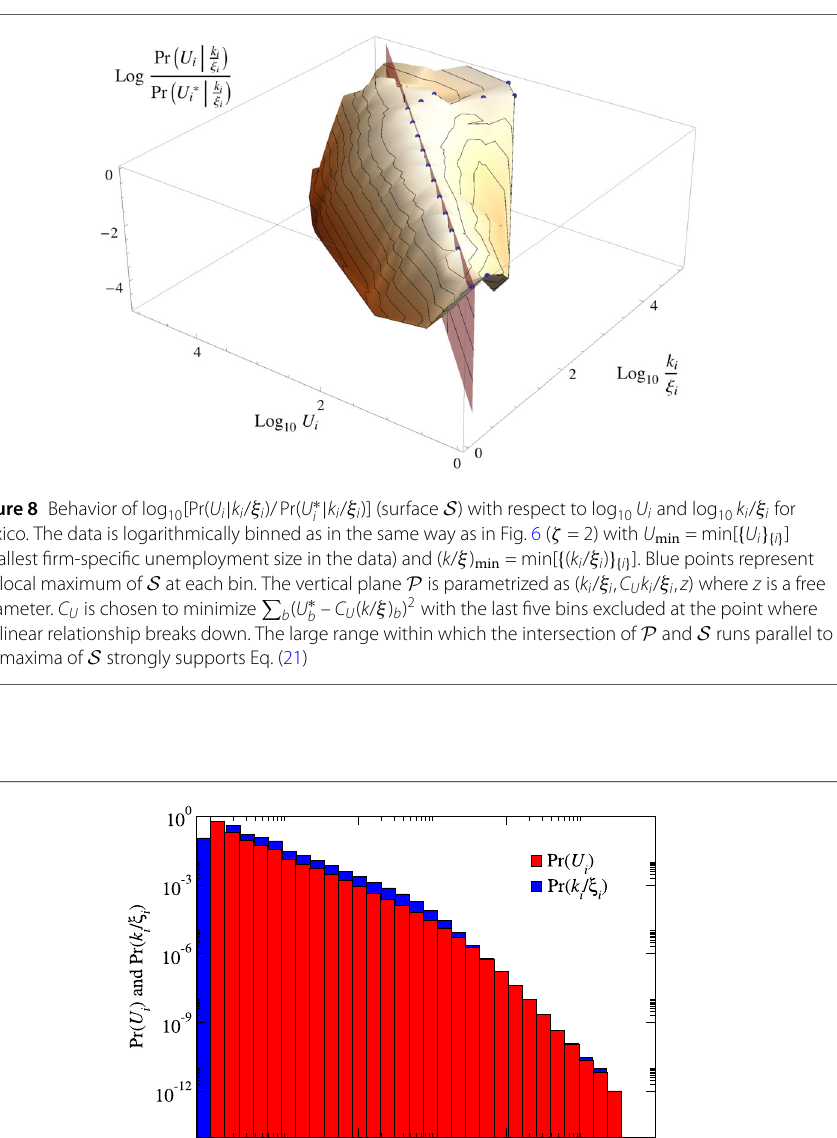
distribution of k i / ξ i . The parallel between the two distributions mirrors the situation with L i and k i / λ i : Eq. (21), which connects U i to k i / ξ i , allows explaining Pr ( U i ) dU i through a change of variables so that Pr ( U i ) dU i = Pr ( k i / ξ i ) d ( k i / ξ i ). This plot also indicates the pres- ence of a heavy-tail distribution for Pr ( U i ). Some care must be taken in interpreting Fig. 9 due to the way in which the Mexican data was collected, focusing on uniformly sampling individuals rather than firms. This may play a role in the cross-over in slopes observed in the distributions of both U i and k i / ξ i